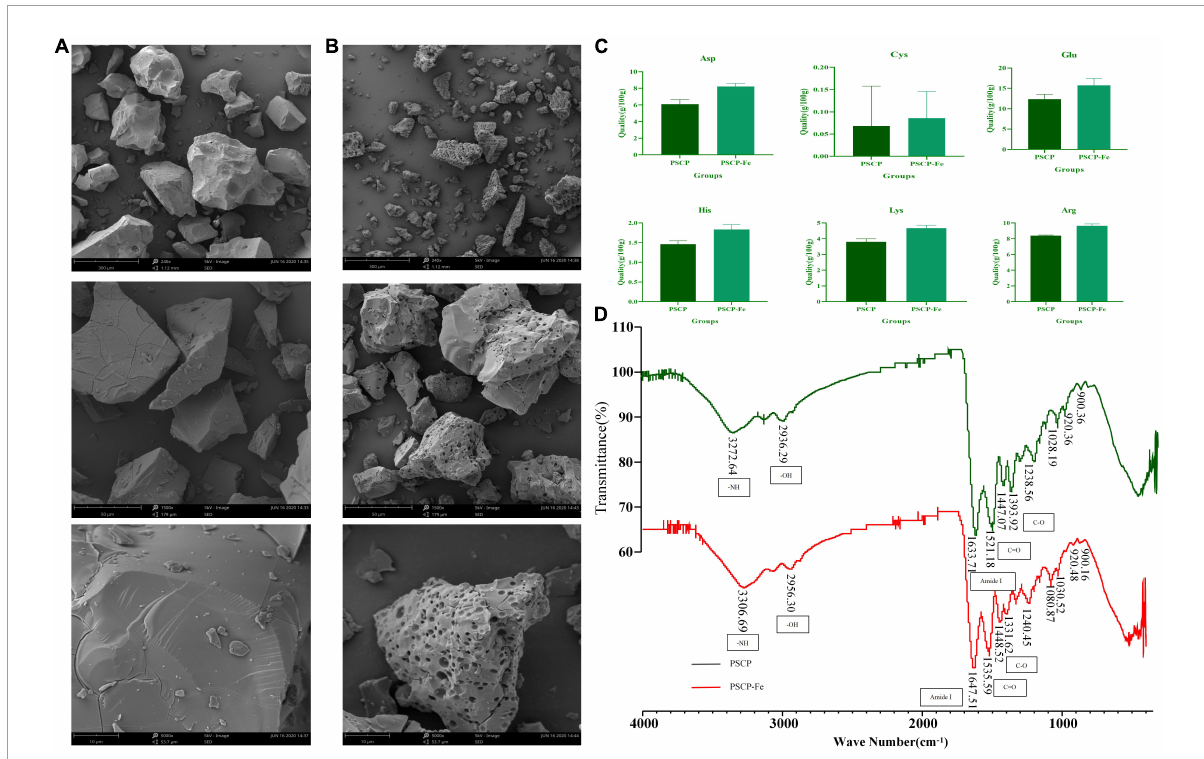
FIGURE1 The scanning electron microscopy of PSCP (A) and PSCP-Fe (B) . Differences in amino acid content between PSCP and PSCP-Fe (C) . The FTIR spectroscopy of PSCP and PSCP-Fe (D)